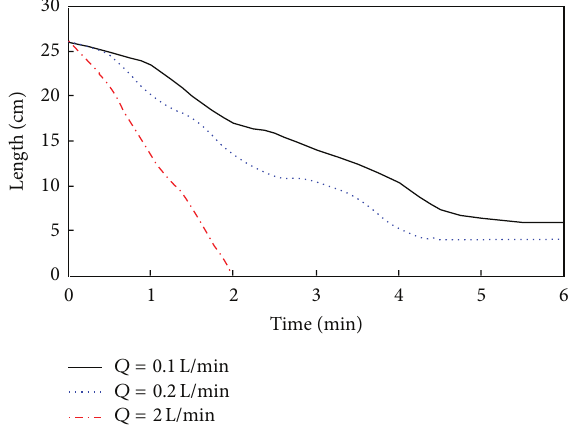
Figure 8: Evolution of the length of the top of landslide dams under different water flow